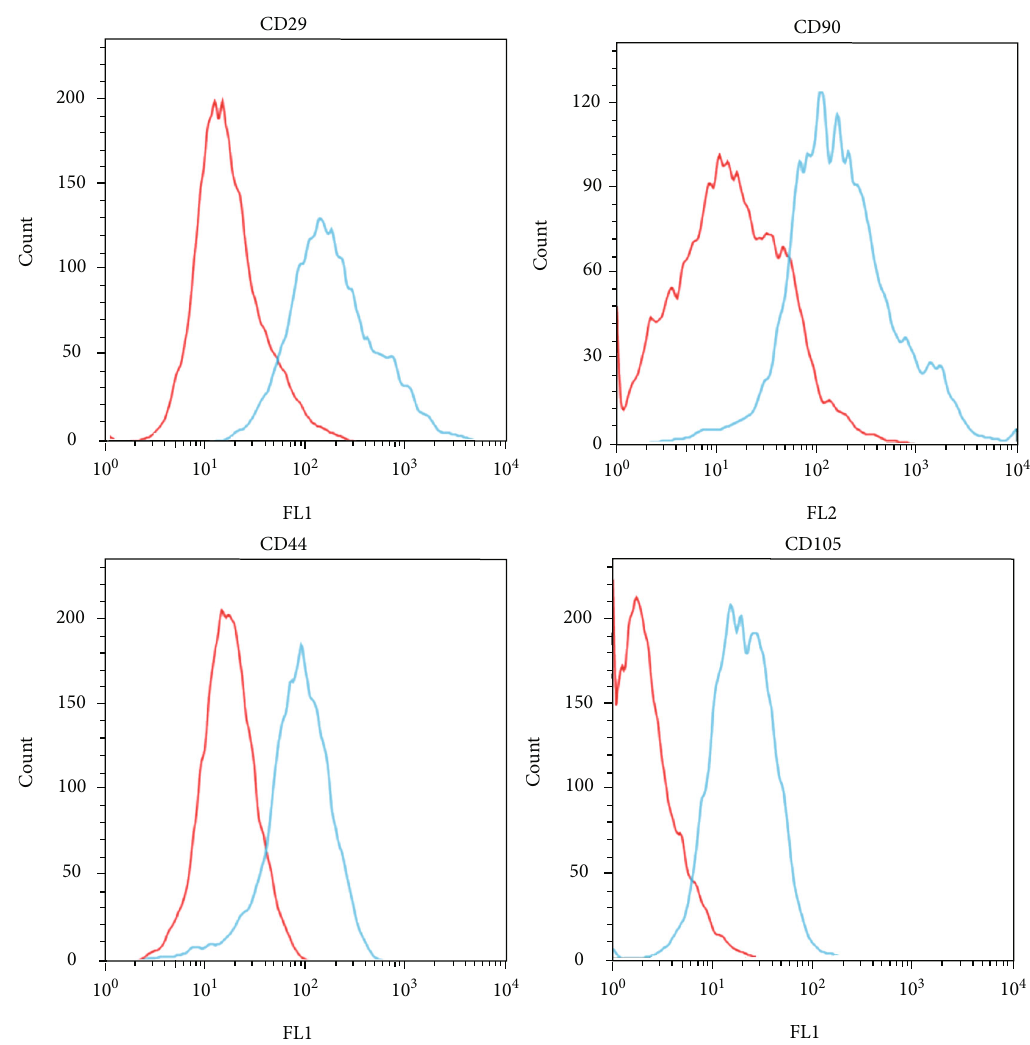
Figure 1: MSC markers decreased upon transition of ADSCs to mSCLCs. Human ADSCs were seeded onto 60mm dishes and cultured in a complete medium or a SC medium supplemented with ALK5 i II for 14 days. Flow cytometric analysis was performed to examine CD29, CD44, CD90, and CD105 expression on the cell surface. Representative histograms for ADSCs (blue line) and mSCLCs (red line) are